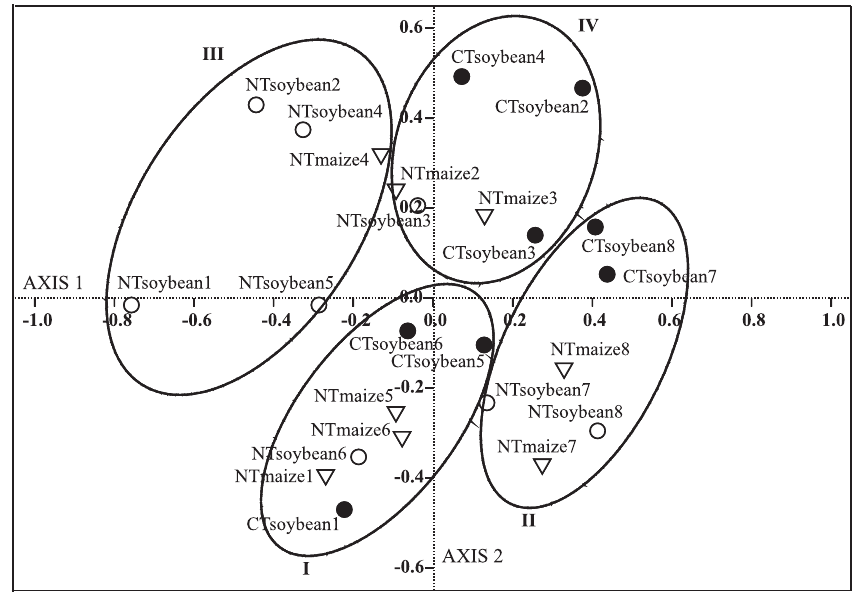
Figure 3. Scatter diagram of the variables and tillage systems (conventional-CT and no-tillage-NT) evaluated after soybean (CTsoybean and NTsoybean) and after maize harvest (NTmaize), in eight samplings (1– 8), in the crop rotation black oat/soybean/black oat+common vetch/maize/radish oil/wheat/soybean under Rhodic Hapludox during autumn (May 7 to 30, 2007), in Southern Brazil. The clusters formed by the similarity between the management systems are indicated as I, II, III, and